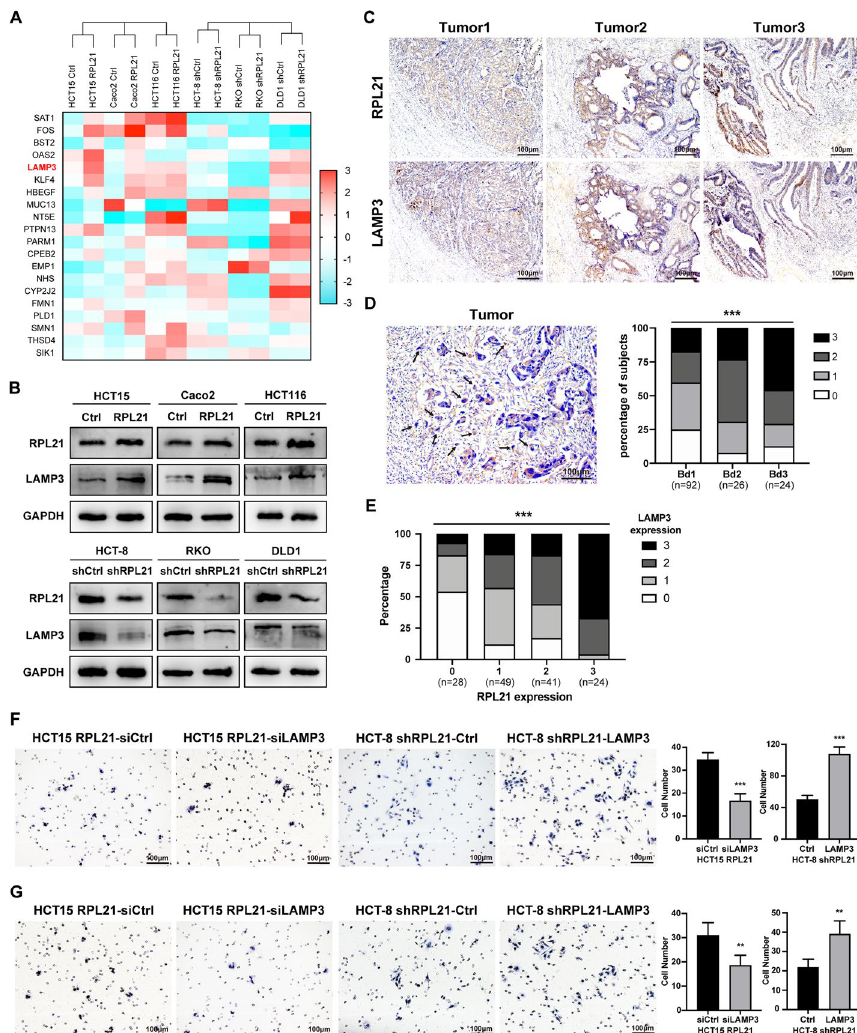
Fig. 3 LAMP3 is significantly correlated with RPL21 and promotes the migration and invasion of CRC. A Heatmap of the top 20 differentially expressed genes in the transcriptome sequencing of RPL21 stable overexpression and knockdown cells with their control cells. B LAMP3 protein expression in RPL21 stable overexpression and knockdown cells detected by western blotting. C The representative images of RPL21 and LAMP3 expression in 142 paraffin-embedded human CRC tissues (tumor 1, tumor 2, and tumor 3) detected by IHC staining (scale, 100 μm). D The representative image of LAMP3 expression in CRC tumor buds was detected by IHC staining (scale, 100 μm). The arrowheads indicate the tumor buds. The correlation between the scores of LAMP3 expression in tumor buds and the grades of tumor budding was analyzed. n 142, *** p < 0.001, Kendall’s Tau test. E The correlation between the scores of RPL21 and LAMP3 expression = in tumor buds was analyzed. n 142, *** p < 0.001, Kendall’s Tau test. F The migration ability of the indicated = CRC cells was detected by the transwell migration assay (scale, 100 μm). Mean SD, n 5, *** p < 0.001, ± = Student’s t -test. G The invasion ability of indicated CRC cells was detected by Matrigel-coated Boyden chamber invasion assay (scale, 100 μm). Mean SD, n 5, ** p < 0.01, Student’s t ± =